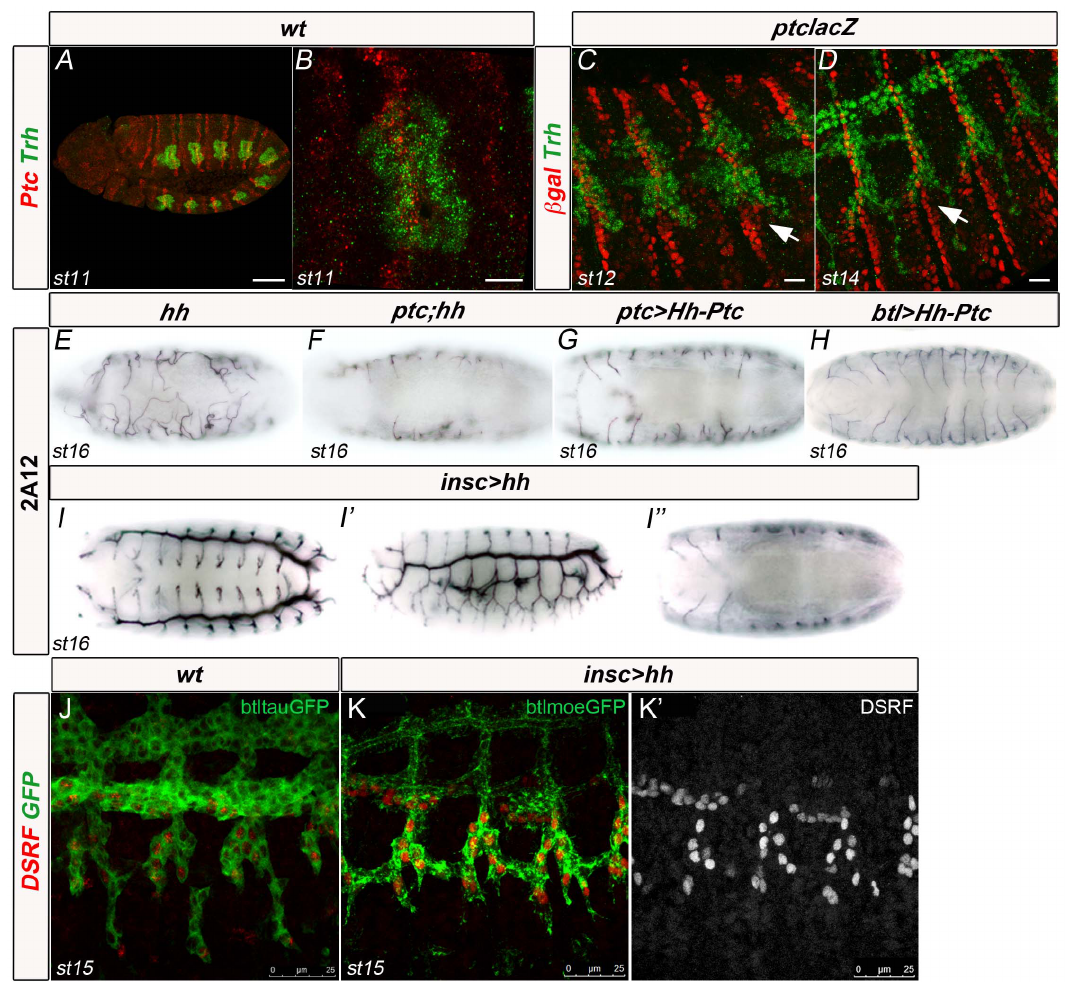
Figure 5. The Hh pathway modulates GB cell migration non-autonomously. (A,B) wt embryos stained with anti-Ptc and anti-Trh antibodies. Ptc protein is detected in vesicles in Ptc-expressing cells. (C,D) ptclacZ embryos stained with anti-ßgal and anti-Trh. Ptc expression is detected by nuclear ßgal presence. Scale bars are 50 m m in A and 10 m m in B–D. (E–H) Ventral views of stage 16 embryos stained with 2A12 to visualise the tracheal lumen. (I–I 0 ) Dorsal, lateral and ventral views of the same stage 16 embryo expressing Hh in the VNC and stained with 2A12. Excess Hh in the VNC phenocopies the ptc mutant tracheal phenotype, but only on the ventral/lateral side of the embryo. (J–K) btl . tauGFP wt stage 15 embryo stained with anti-DSRF and GFP (J) and btlmoeGFP stage 15 embryos overexpressing Hh in the VNC and stained with anti-DSRF and GFP (K) or only DSRF (K 9 ).